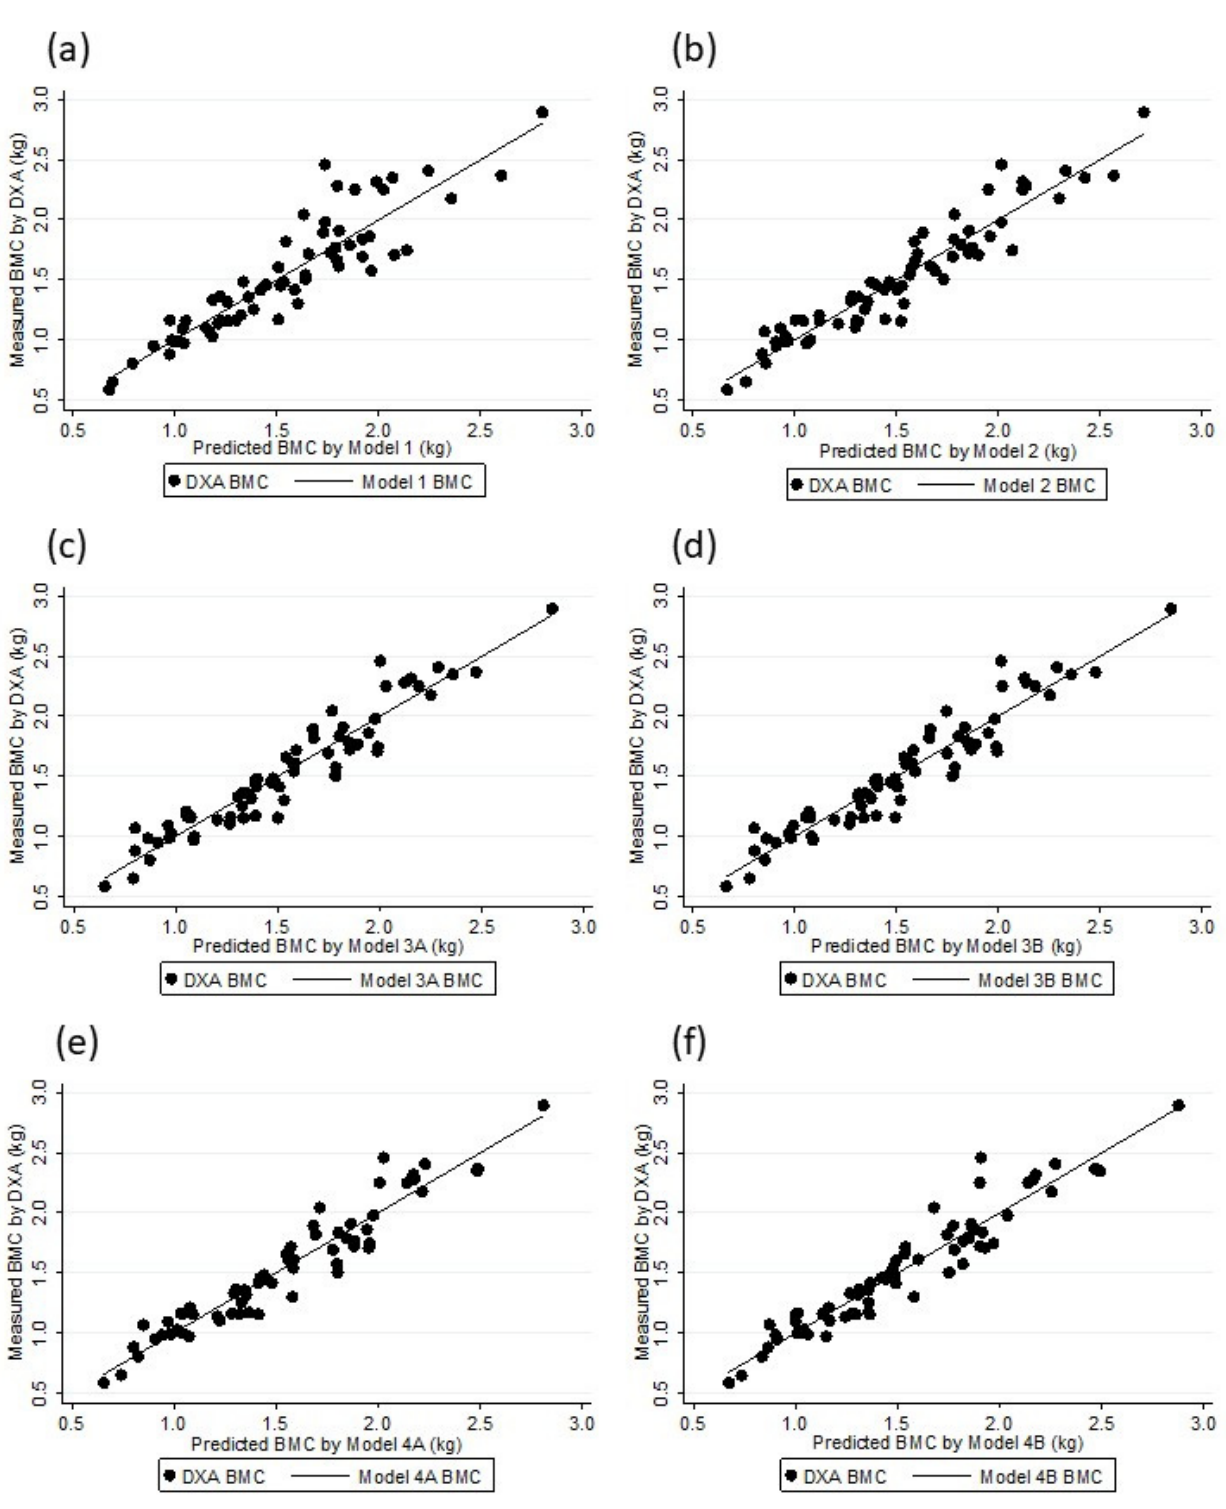
Figure 1. DXA BMC and Models BMC association: Model 1 ( a ), Model 2 ( b ), Model 3A ( c ), Model 3B ( d ), Model 4A ( e ), and Model 4.B ( f ).